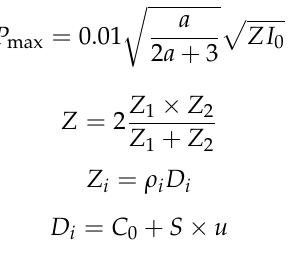
Figure 3. Regular and irregular (Mach) wave reflection.